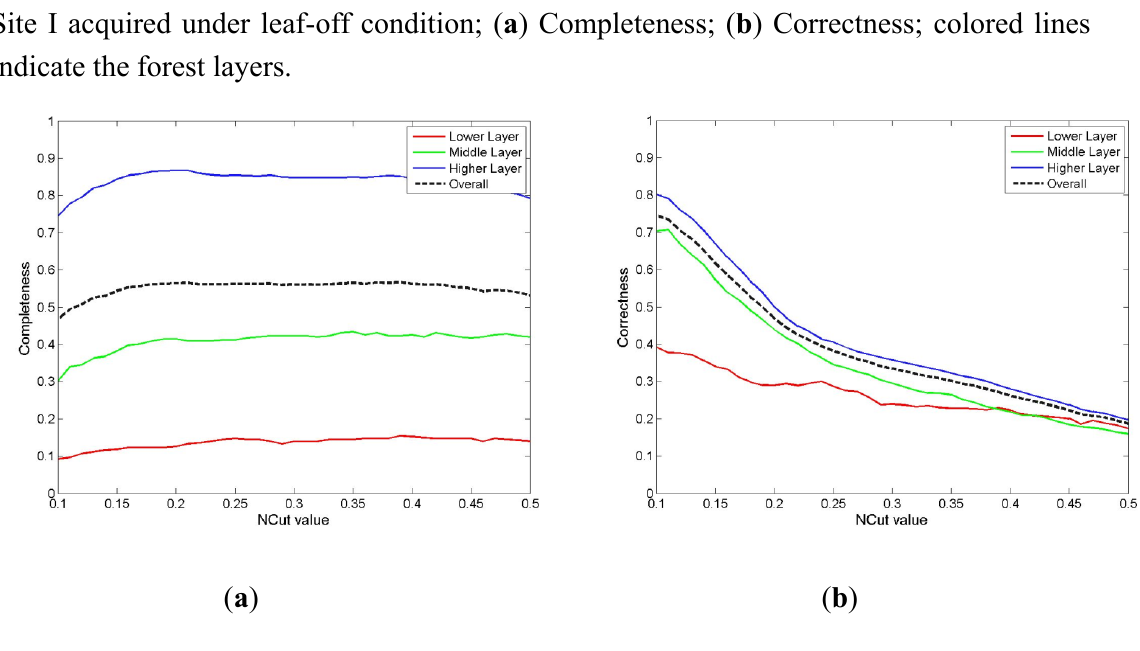
for the dataset of Test Thres